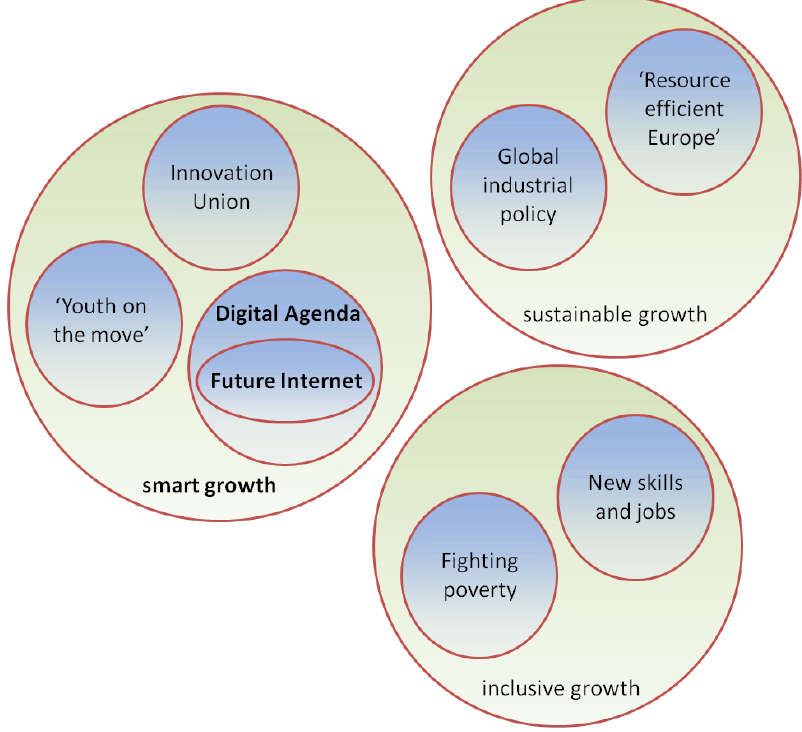
Figure 2. Future Internet and the Europe 2020